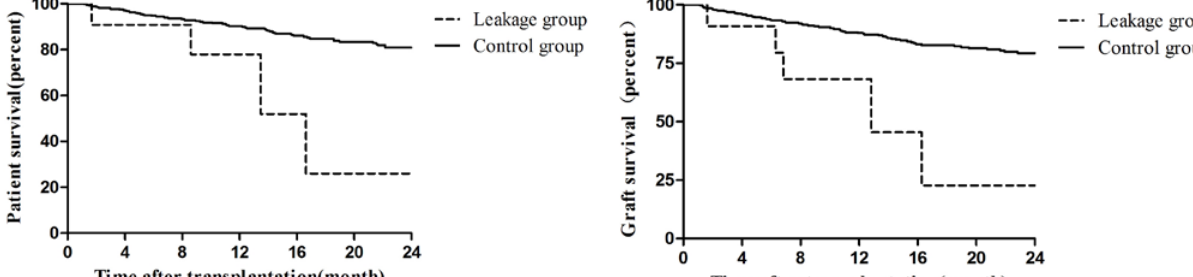
Figure 2: Patient survival curve of the two groups. Figure 3: Graft survival curve of the two